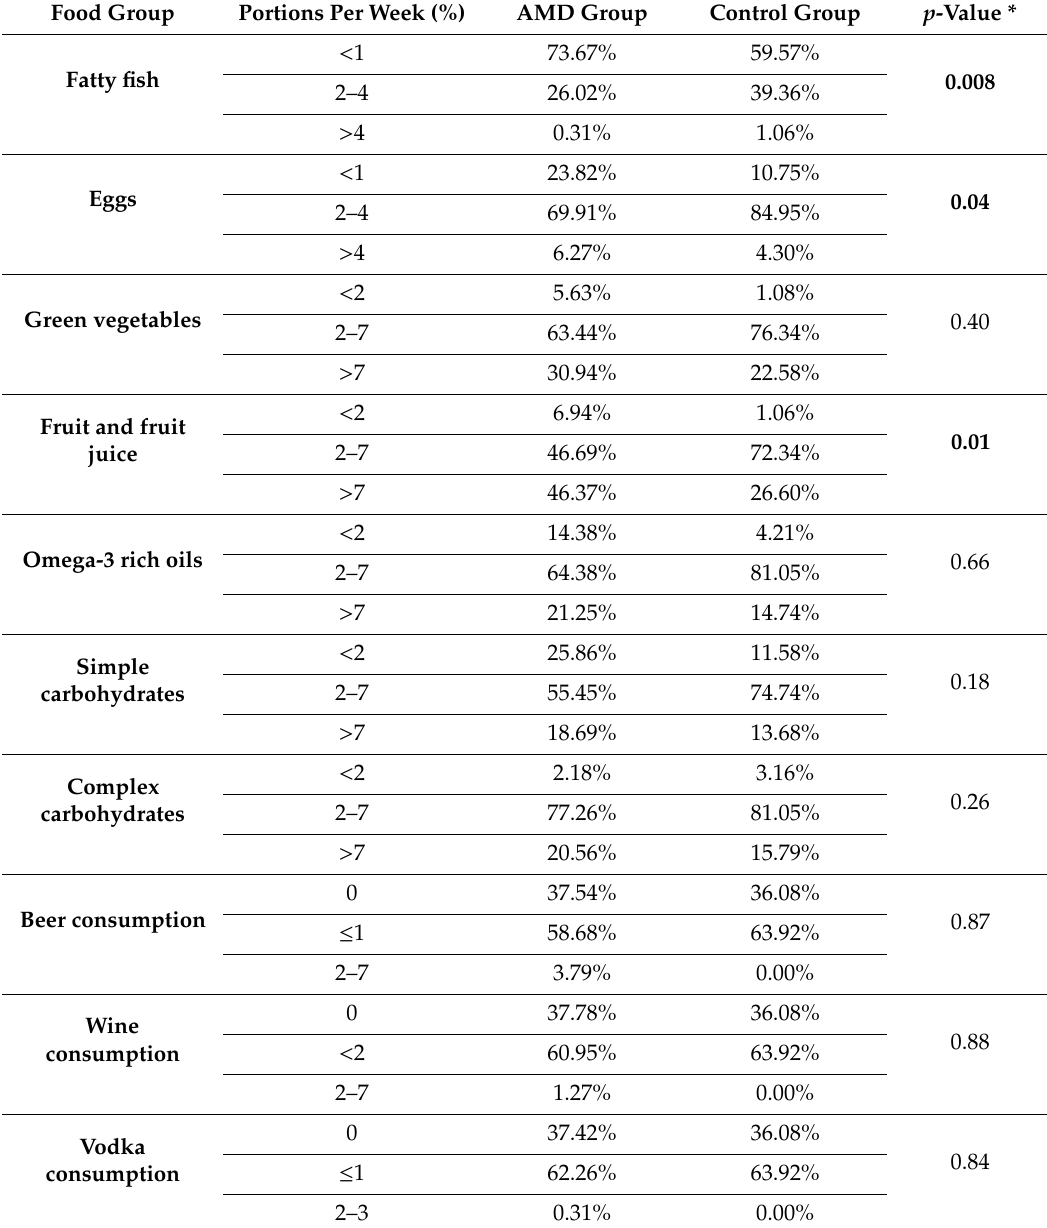
Table 2. Dietary habits of the AMD group and control group. p -values < 0.05, which were considered statistically significant, are shown in